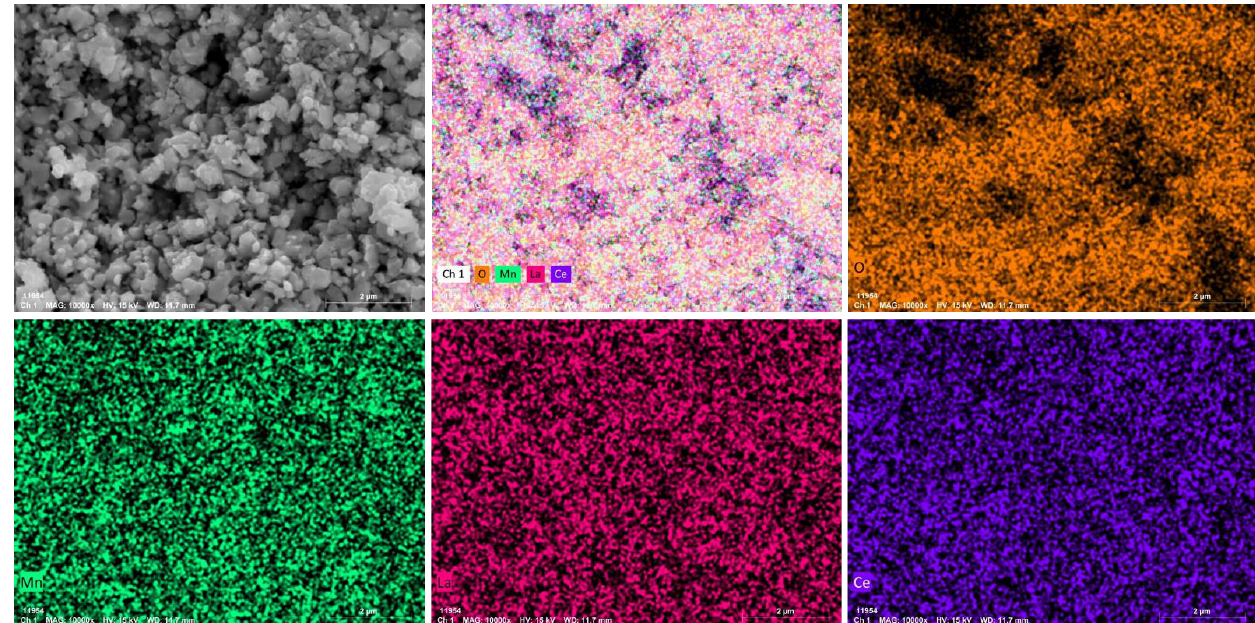
Figure 11. EDS spectra of 0.3LCMO after circulation.